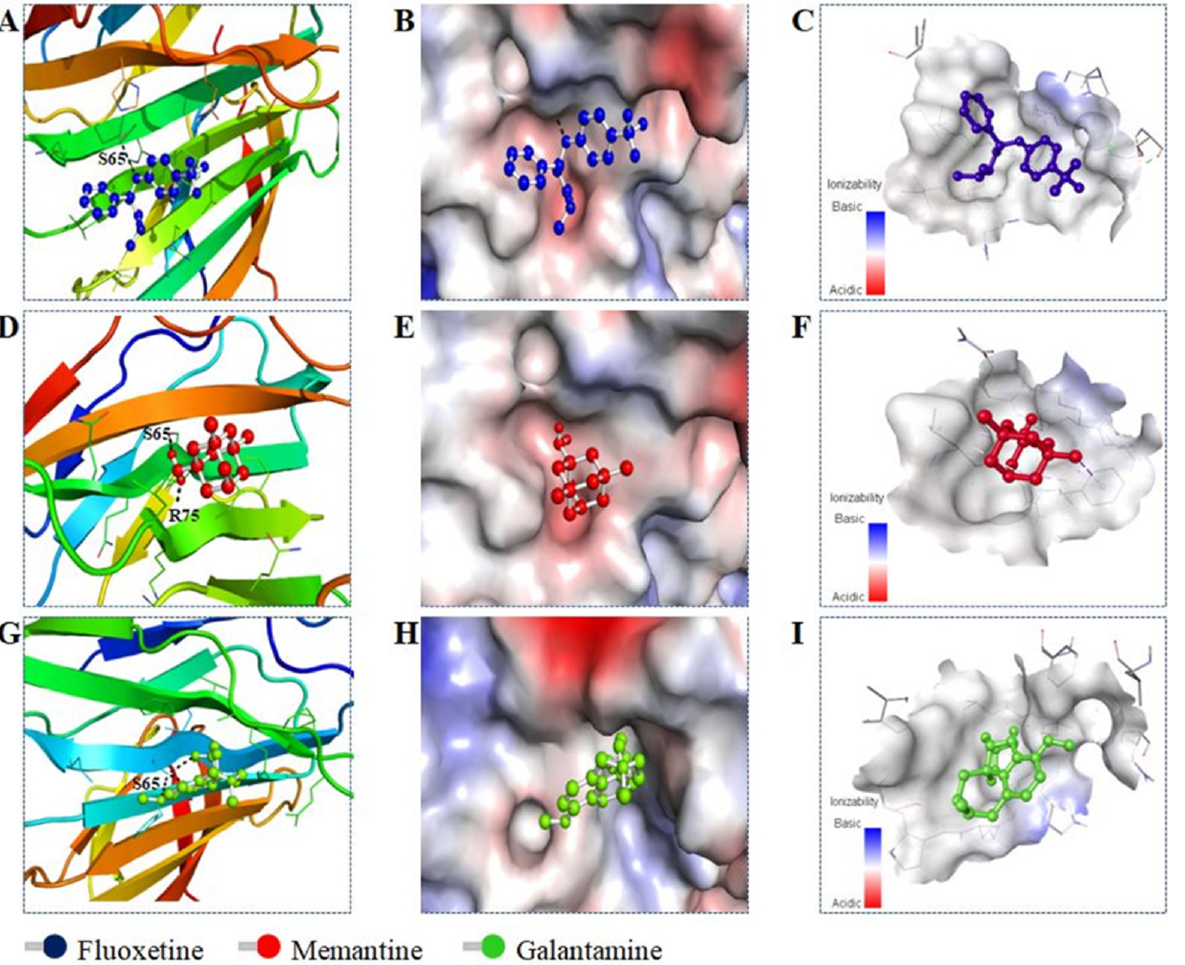
Figure 6. ( A , D , G ) Cartoon representation showing the interaction of irisin with fluoxetine, memantine, and galantamine, respectively. ( B , E , H ) Potential surface representation of the binding pocket and its interaction with fluoxetine, memantine and galantamine, respectively. ( C , F , I ) Zoomed surface view of the irisin binding pocket occupied by fluoxetine, memantine, and galantamine, respectively.